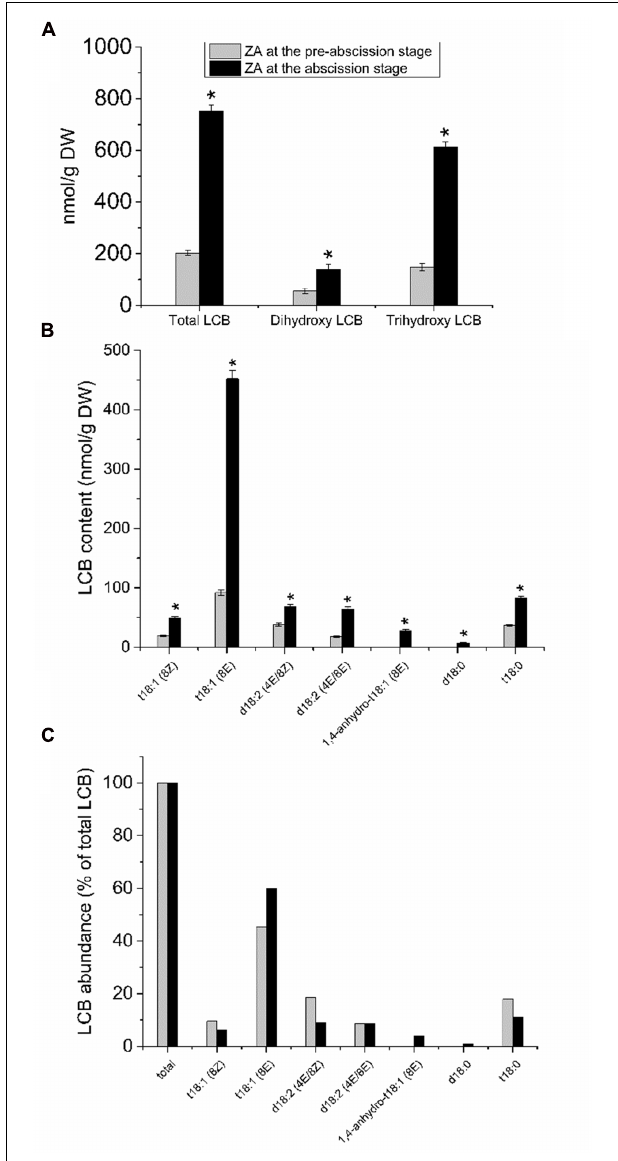
FIGURE 4 | Sphingolipid LCB content and composition of olive AZ during mature-fruit abscission. (A) The total LCB content and the relative content of dihydroxy or trihydroxy LCBs in total LCB extracts, (B) profiles of LCBs, and (C) relative abundance of the different LCB from olive-fruit AZ at two different stages (pre-abscission and abscission). C-The content of every LCB species detected is expressed as a percentage of the total LCB content. Data are the means of three independent biological repeats. Statistically significant differences based on unpaired Student’s t -test at P < 0.05 are denoted by asterisk. t18:1(Z)-Glc, t18:1(E)-Glc, d18:2(4E/8Z)-Glc, d18:2(4E/8E)-Glc, d18:1(8Z)-Glc, d18:1(8E)-Glc, d18:1(8Z), d18:1(8E), d18:1(4E), d18:2(4E/8E), 1,4-anhydro-t18:1(8Z) and 1,4-anhydro-t18:0 were undetectable in both stages of the ZA.